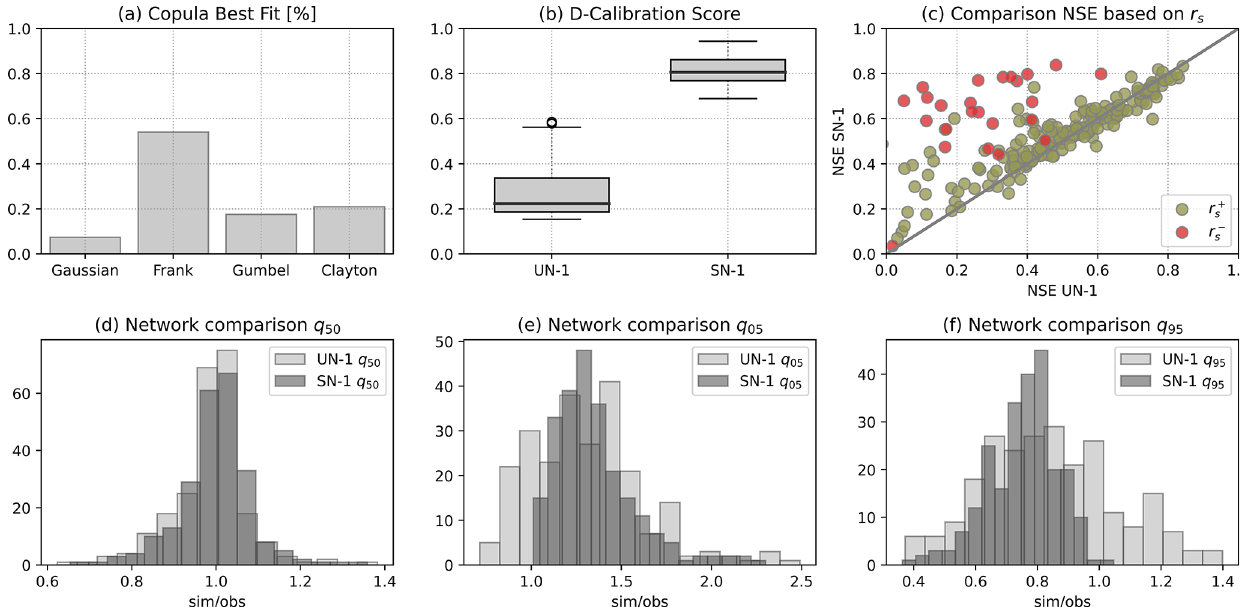
Figure 5. Results of the testing process when the UN-1 and SN-1 networks are used as descriptive models of the 240 catchments considered as single elements. Panel (a) shows the percentage of pairs with the copula on the x axis as best fit. Panel (b) shows the variability of the d -calibration score across catchments. Panel (c) shows the comparison between UN-1 and SN-1 in terms of NSE as a function of the sign of the correlation ( r s ) between Q max and P max . Red dots indicate negative correlation ( r − s ), while green dots ( r + s ) indicate positive correlation. The identity line (grey) is used as an indicator to visually compare the results from UN-1 and SN-1 networks. Dots on the line indicate matching results between the two networks, while dots above/below the line indicate higher values of NSE associated with the NS-1/UN-1 network. Panels (d) to (f) show the histograms of the ratio between simulated and observed discharge quantiles, i.e. 0 . 5, 0 . 05, and 0 . 95th quantiles, for the UN-1 (light grey) and SN-1 (dark grey) network. Panel (d) shows that the UN-1 and SN-1 networks simulate the 0 . 5th quantile similarly, while panel (e) and (f) show that the SN-1 network generally over- and underestimates the 0 . 05 and the 0 . 95th quantile respectively. Panel (e) and (f) show also that the UN-1 network does not have a clear tendency to over- or underestimate the quantiles.